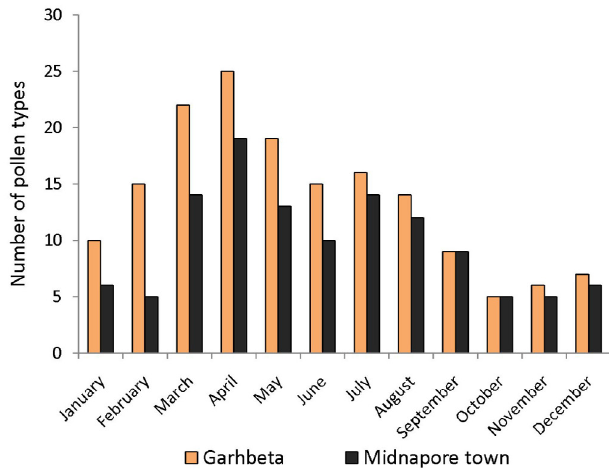
Fig 3 . Month-wise richness of pollen types in Garhbeta and Midnapore town of West Bengal.